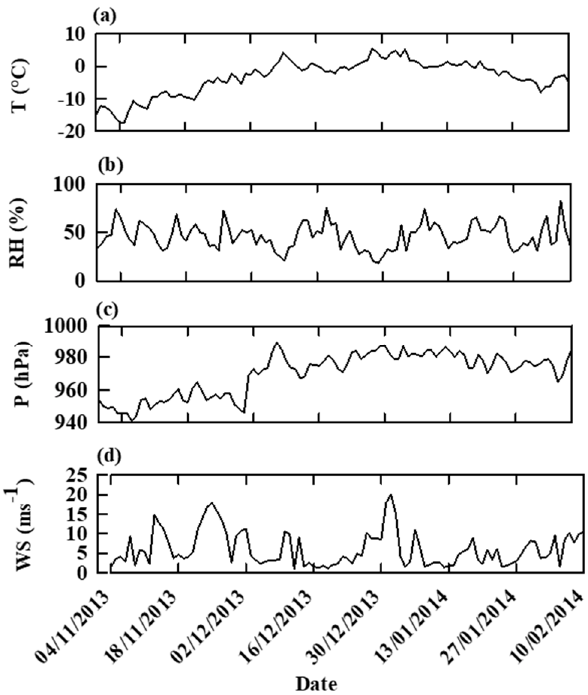
Figure 2. Meteorological parameter variations at Faraglione Camp during the sampling period. The panels ( a – d ) show the daily variation of air temperature ( ◦ C), relative humidity (%), pressure (hPa), and wind speed (m s − 1 ), respectively.